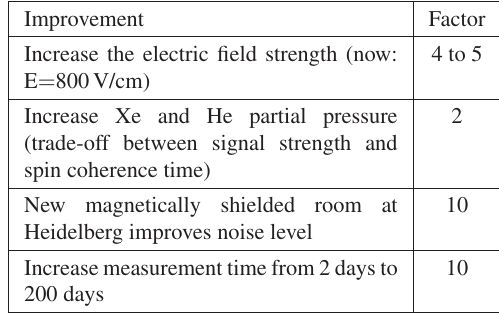
Figure 5. For run number 4; upper part: phase difference (cid:1)(cid:4) after correction for earth rotation and chemical shift, middle part: residual phase difference (cid:1)(cid:4) after the correction for the generalized Ramsey-Bloch-Siegert-shift, lower part: hypothetical EDM signal (cid:4) EDM ( t ) for d Xe = 4 . 0 · 10 − 25 e · cm.